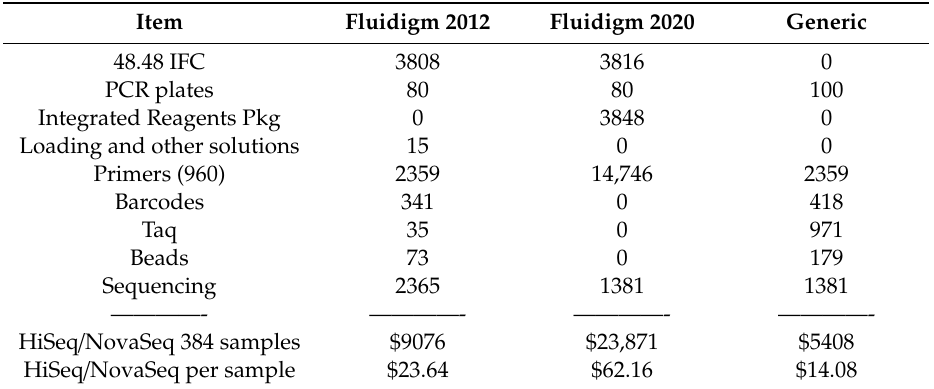
Table 8. Cost analysis for amplicon sequencing for di ff erent chemistries for 384 plate